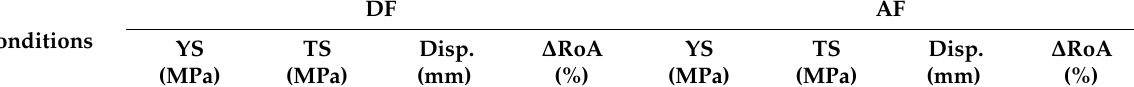
Figure 4. Engineering stress–displacement curves of the WJs with the ( a ) DF and ( b ) AF, as obtained after the slow strain rate testing (SSRT) in the hydrogen-free (HF) and hydrogen-charged (HC) environments. Table 3. Properties of the WJs after the SSRT under the HF and HC conditions.